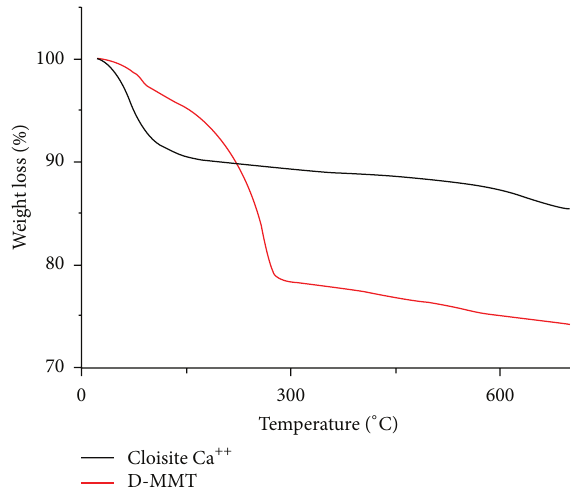
Figure 1: Cation exchange and nanocomposite preparation. Cloisite-Ca: Cloisite Calcium, DPI: diphenyliodonium, ℎ V : UV Light, Nanocom- posite: Poly(Cyclohexene oxide)-Montmorillonite nanocomposite structure.